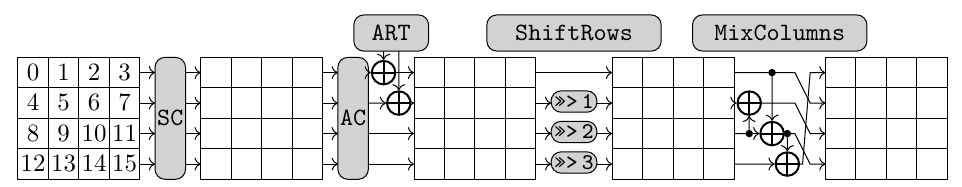
Figure 1: SKINNY Round